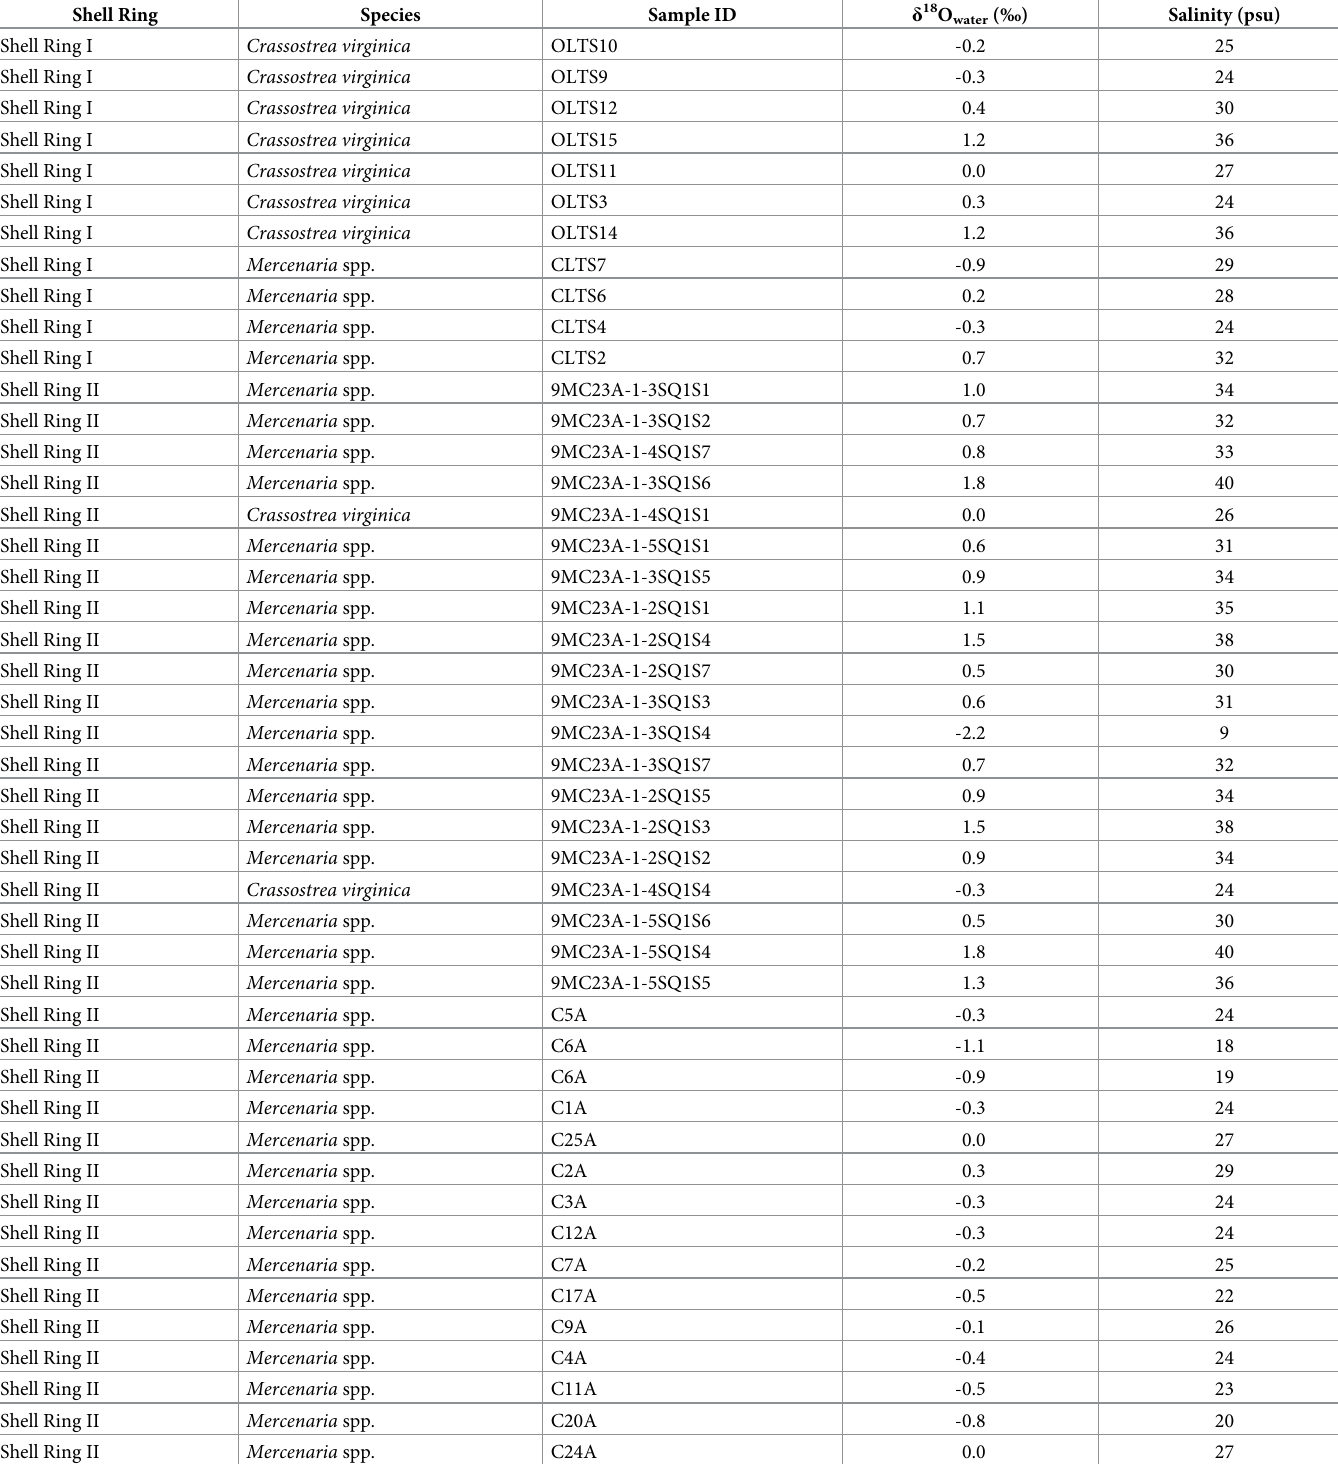
Table 3. Estimated summer δ 18 O water (‰ VSMOW) values modeled after Andrus and Thompson’s (2001) oxygen isotope-temperature equations (Eqs 1 and 2), assuming shell growth cessation at 28˚C for oysters and 31˚C for clams. Salinity (psu) calculated based on Eq 3. Shell